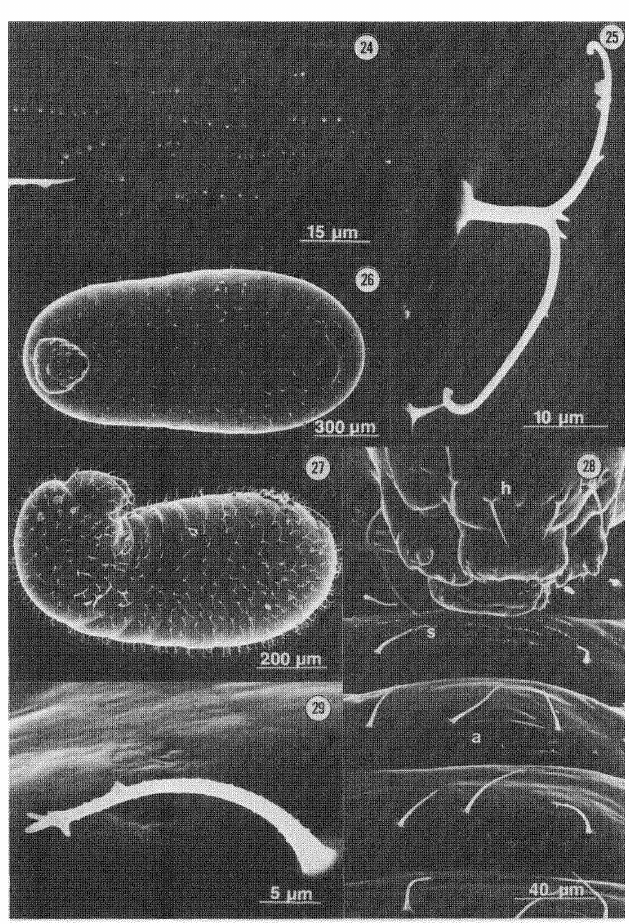
Figs. 24-29. Fig. 24. Posteriorly pointing, ventral spinules of metathorax of Monomorium pharaonis. Fig. 25. Bifid body hairs of M. pharaonis. Fig. 26. Ventral view of M. pharaonis. Fig. 27. Ventrolateral view of Solenopsis molesta. Note simple hairs of anteroventral region (arrow). Fig. 28. Anteroventral region of S. molesta. Note posteriorly ponting, anterior (s) and anteriorly pointing, posterior (a) spinules. Head (h). Fig. 29. Papillose hair from anteroventral region of S.